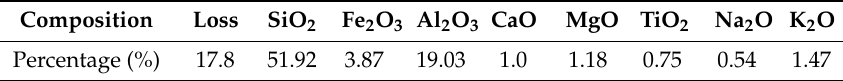
Figure 1. Particle size distribution curves of the coal gangue. Table 1. Chemical composition of coal gangue.